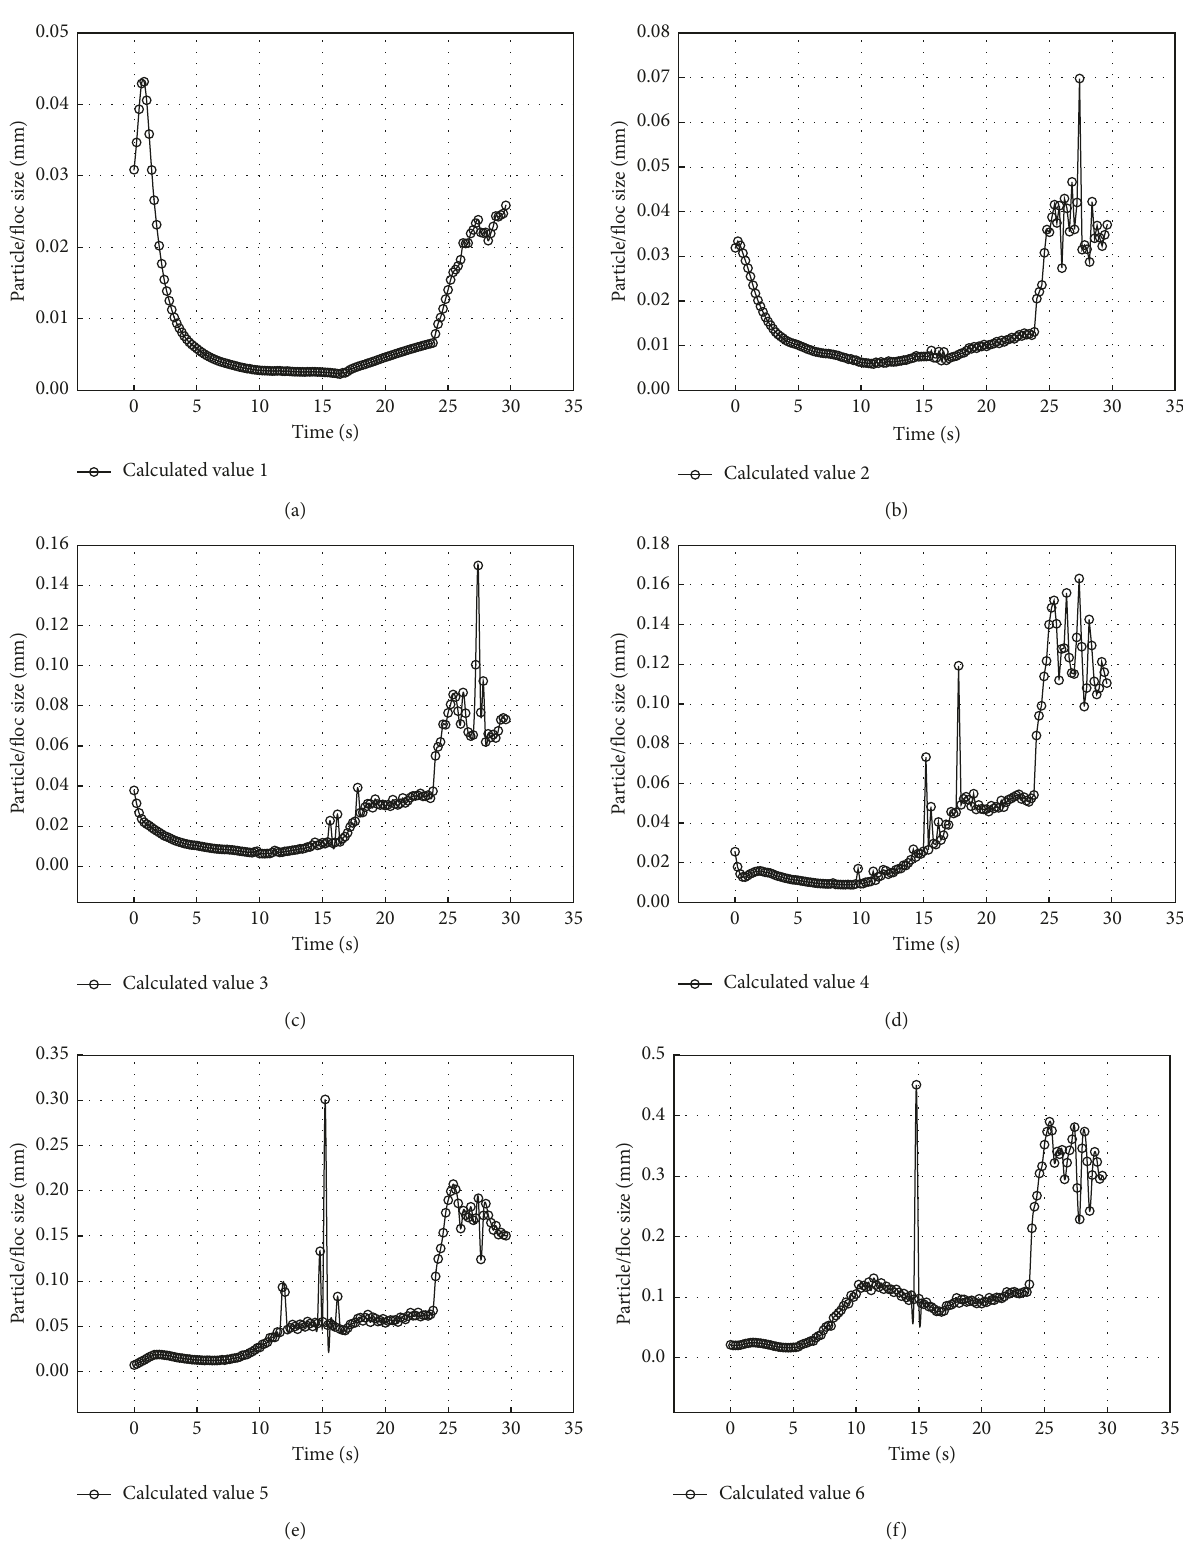
Figure 3: Time series of the particle or floc size of each bin: (a) Bin 0. (b) Bin 1. (c) Bin 2. (d) Bin 3. (e) Bin 4. (f) Bin